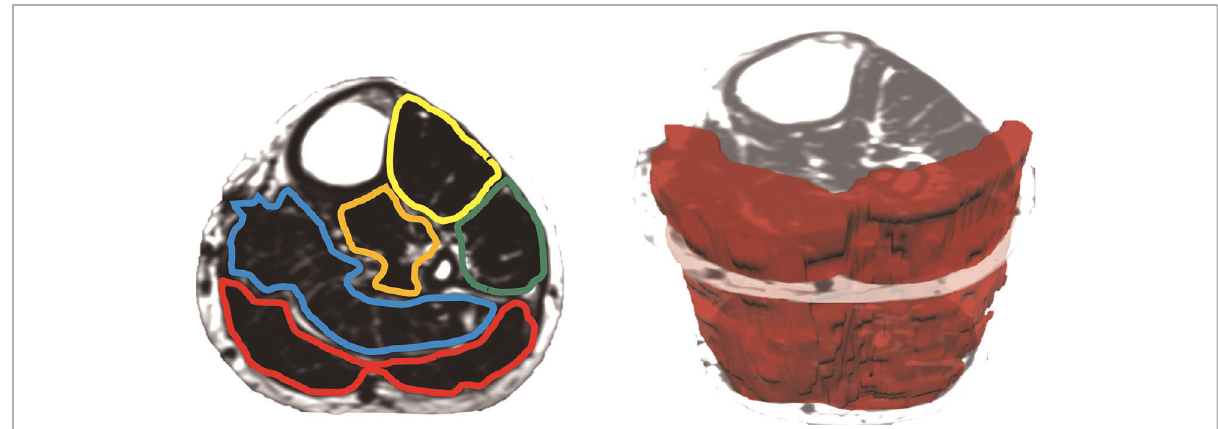
FIGURE 3 Left: one participants ’ fat image of the left leg, with muscle regions of interest contoured (yellow: dorsi fl exors, green: peroneus, orange: tibialis posterior, blue: soleus, red: gastrocnemius). Muscle fat in fi ltration was observed within each region of interest. Right: muscle volumes were created by multiplying the cross-sectional area at each slice by the slice thickness (gastrocnemius volume depicted in red).